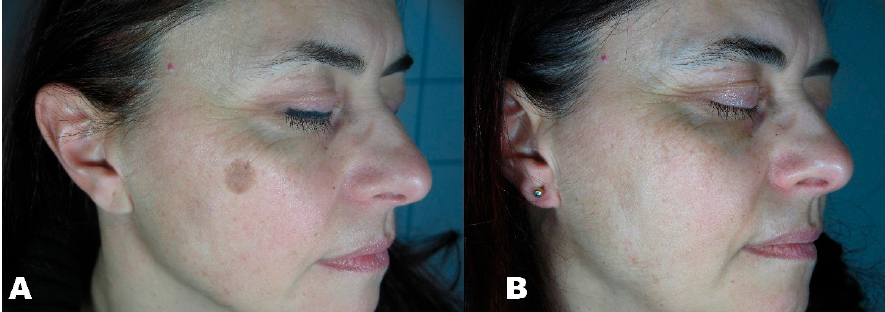
Figure 3. ( A ) Solar lentigo before treatment. ( B ) region three months after the last session.